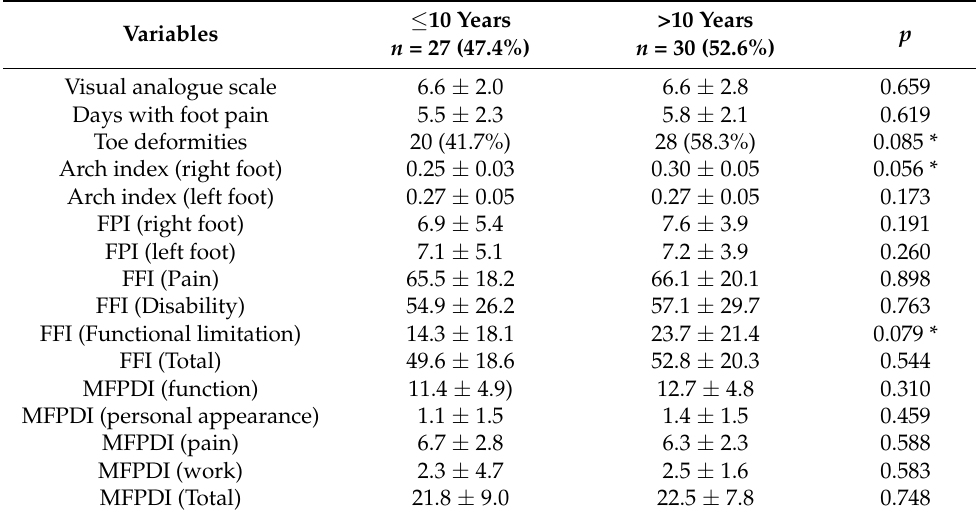
Table 3. Descriptive values and comparisons of the quantitative variables between those participants with 10 years or less with RA and those with more than 10 years with RA.